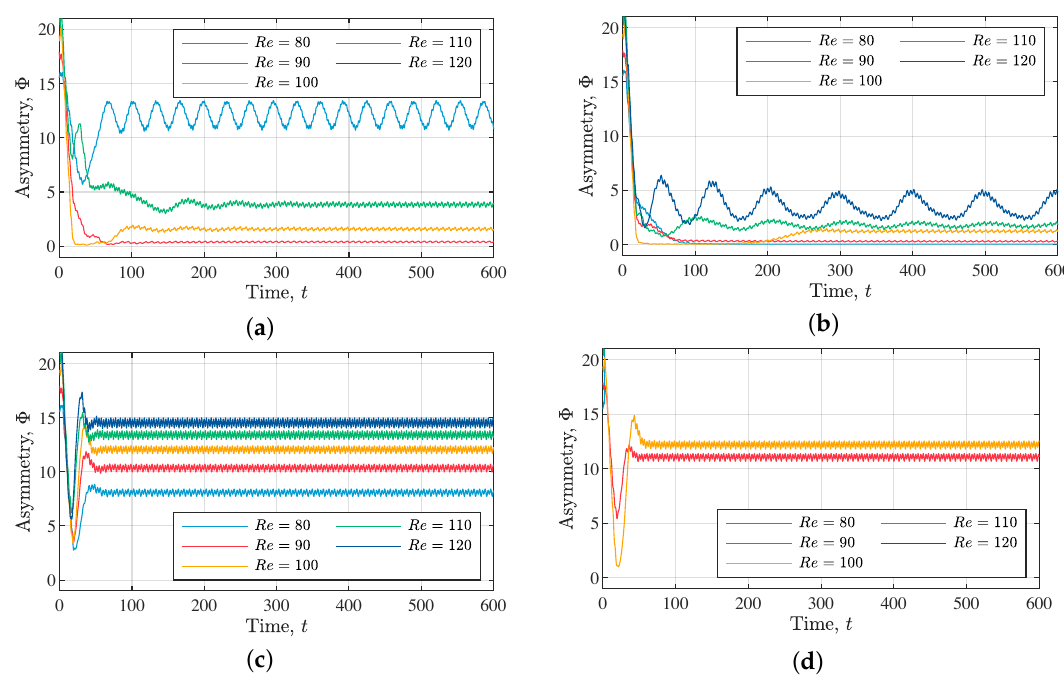
Figure 15. Histories of the asymmetry functions under the control laws for Re = 80, 90, 100, 110, and 120. ( a ): the control law (SF-1), ( b ): the control law (SF-2), ( c ): the control law (OF-1), ( d ): the control law (OF-2). Some lines in ( a ) and ( d ) are hardly seen because the control input diverges immediately after the control